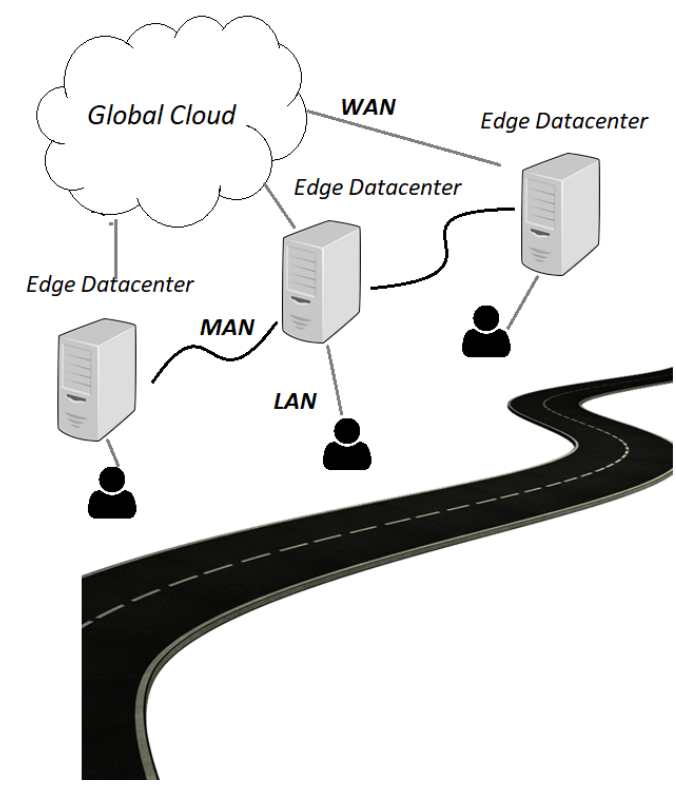
Figure 2. Network